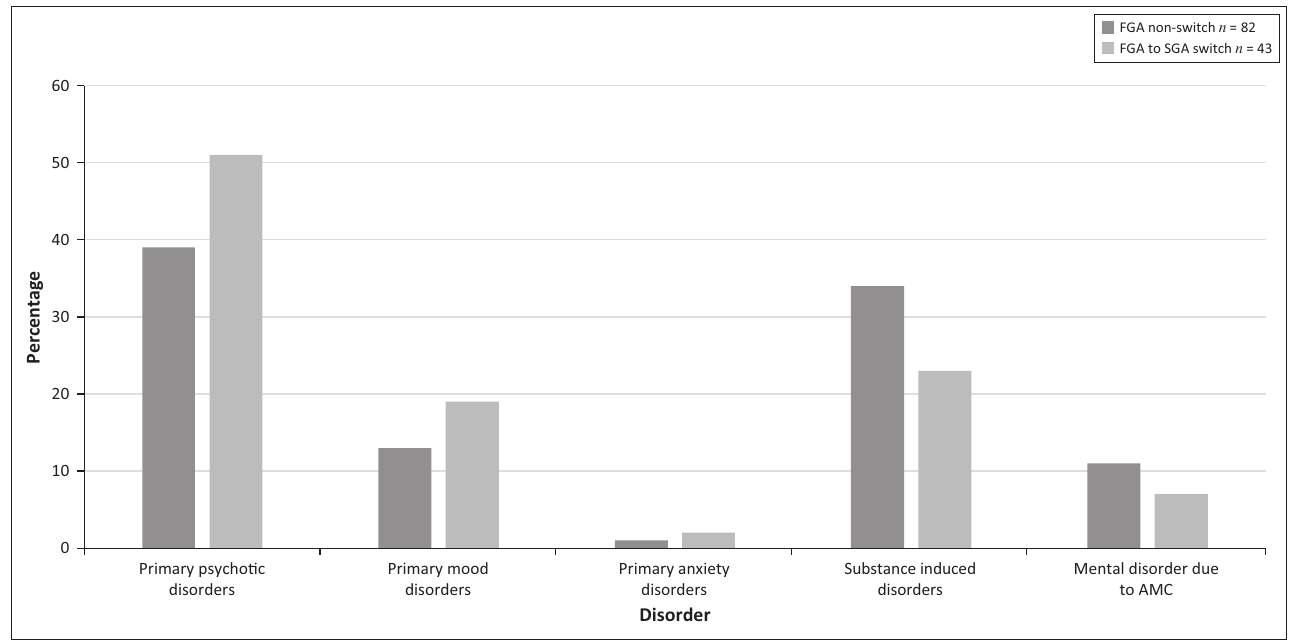
FIGURE 6: Diagnostic distribution of switch and non-switch